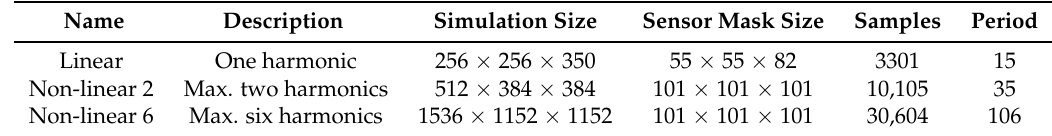
Table 1. The types of testing signals. All signals represent an acoustic pressure.